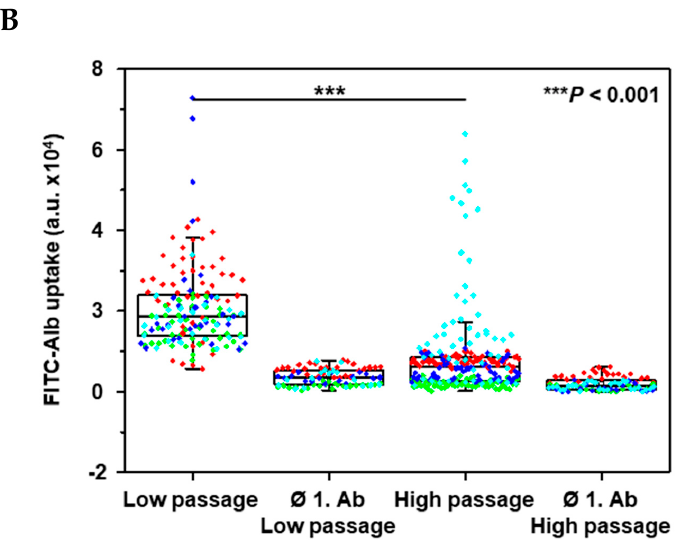
Figure 4. Uptake of FITC-albumin (Alb) in low and high passage WKPT-0293 Cl.2 cells. ( A ) Cells were exposed to 100 nmol/L FITC-Alb (green) in SFM mod for 24 h. Subsequently, cells were fixed, and mounted for fluorescence imaging. Nuclei were counterstained with Hoechst 33342 (blue). The experiment is representative of four similar ones. Scale bar = 20 µm. ( B ) Fluorescence intensity was analyzed in 83–238 cells (dots) from 4 different experiments (colors). For details of box plot statistics, see Section 4.2. Statistical analysis compared the low and high passage cells by non-parametric one-way ANOVA (Kruskal-Wallis-Test, using Dunn’s post-hoc analysis.